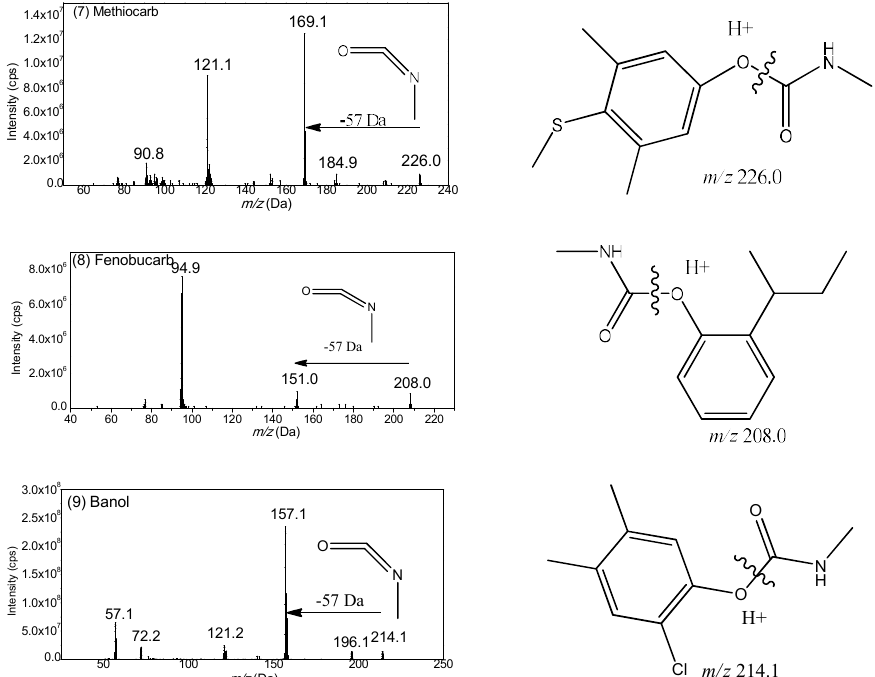
Figure 4. Product ion spectra and proposed fragmentation pathway of nine N-methyl amino formic acid aromatic ester: ( 1 ) Carbofuran-3-hydroxy; ( 2 ) Tsumacide; ( 3 ) Propoxur; ( 4 ) Carbofuran; ( 5 ) Carbaryl; ( 6 ) Isoprocarb; ( 7 ) Methiocarb; ( 8 ) Fenobucarb; and ( 9 ) Banol.